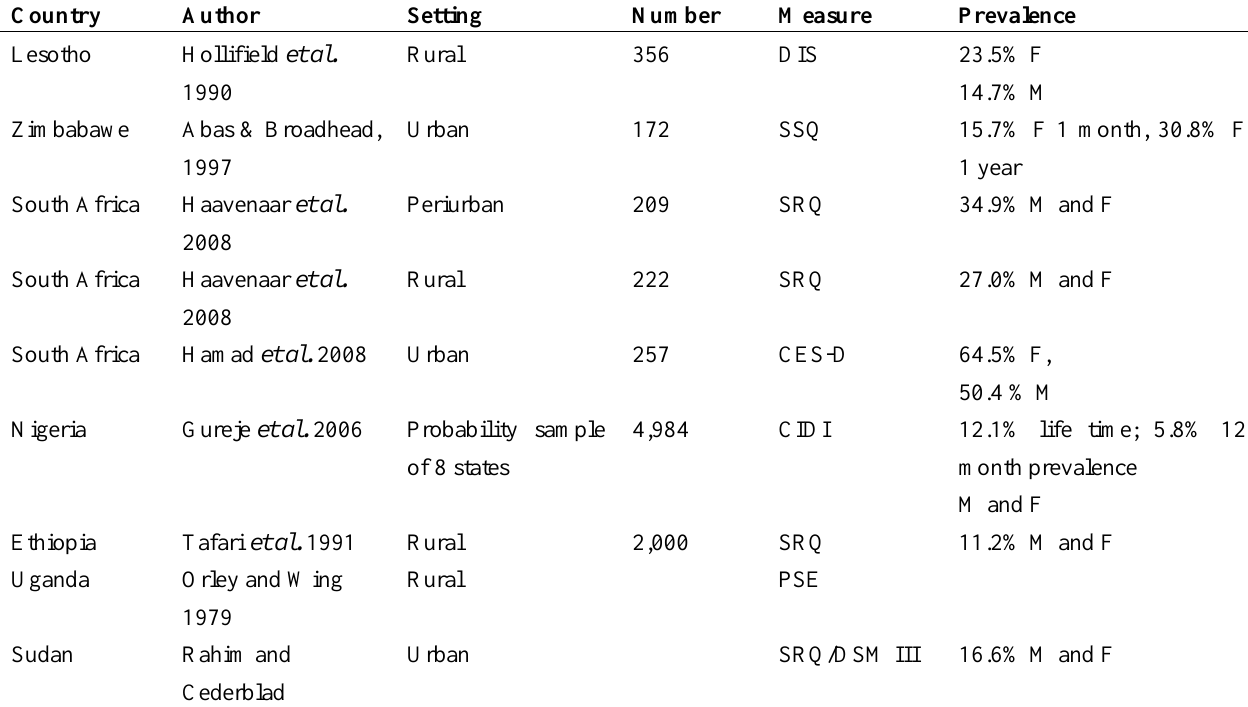
Table 5. Prevalence studies of common mental disorders in sub Saharan